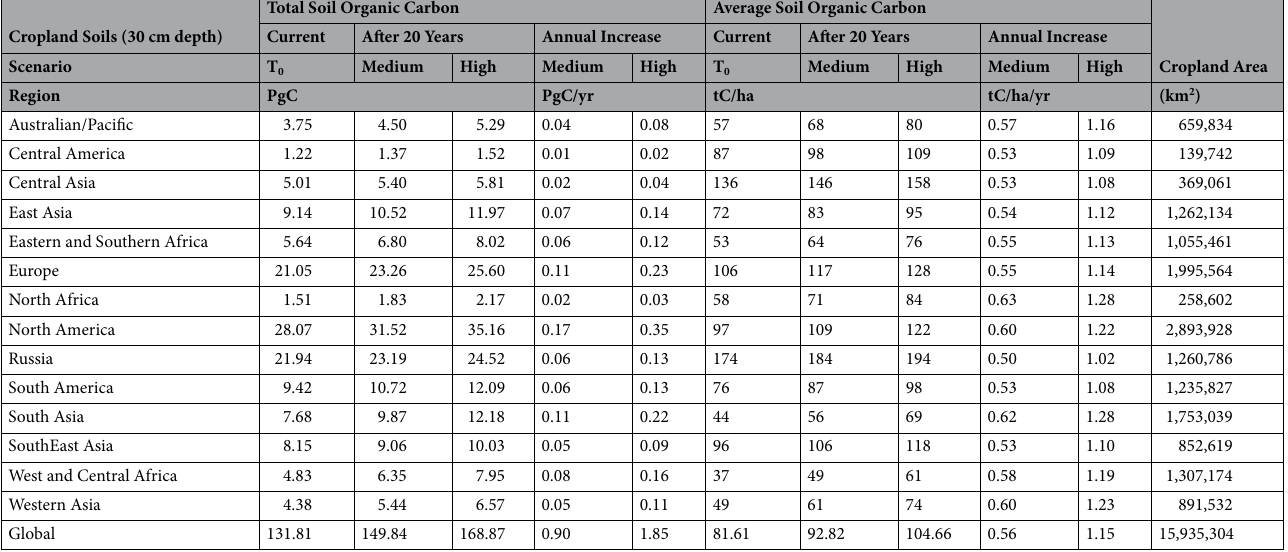
Table 2. Regional Analysis of Available Soils: Soil organic carbon (SOC) for all available cropland soils by region (i.e. those not excluded from the analysis as high SOC or sandy soils), showing both the regional totals and the regional averages per hectare, at current status (T 0 ), and after 20 years for both the medium and high sequestration scenarios, and their annual